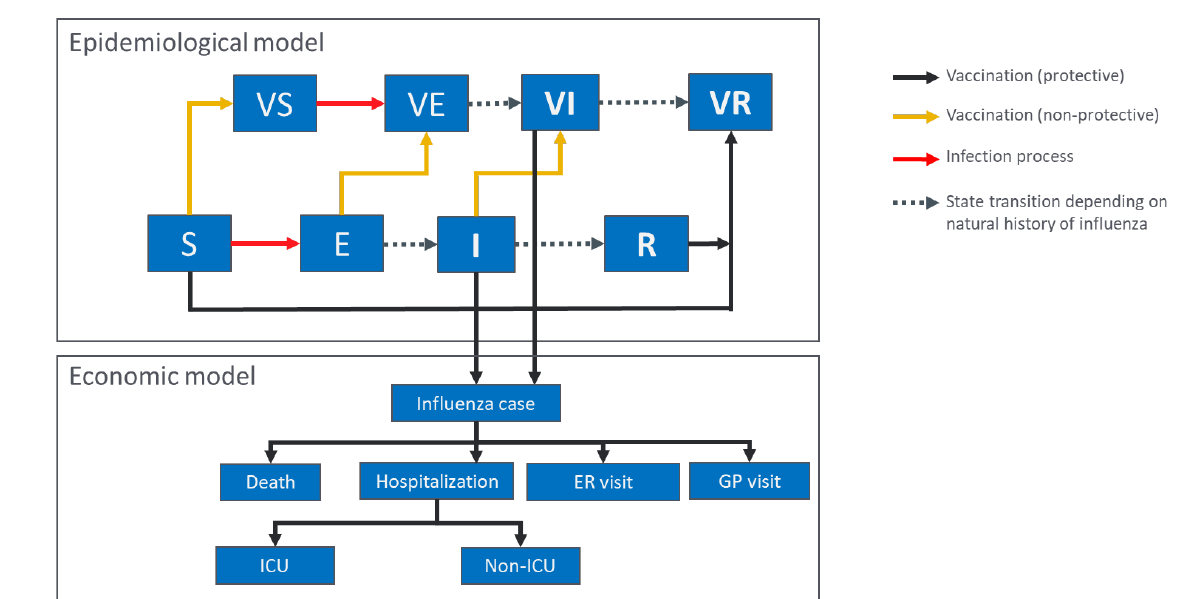
Supplementary Table S1). Birth and death rates were set as equal to maintain a constant population size and population distribution among age classes.